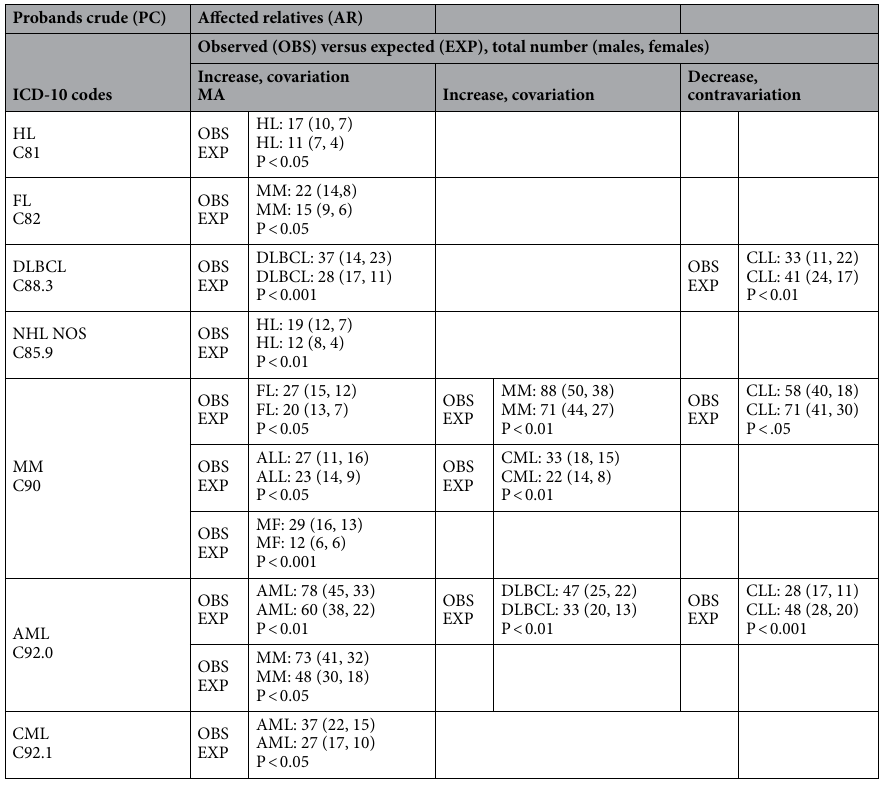
Table 1. In HL for example: HL represents 8.7% of all Faroese LPD (Table 1). According to our joint database, 121 AR LPD (68 males and 53 females) are related to HL so that the expected number of AR HL is 8.7% of